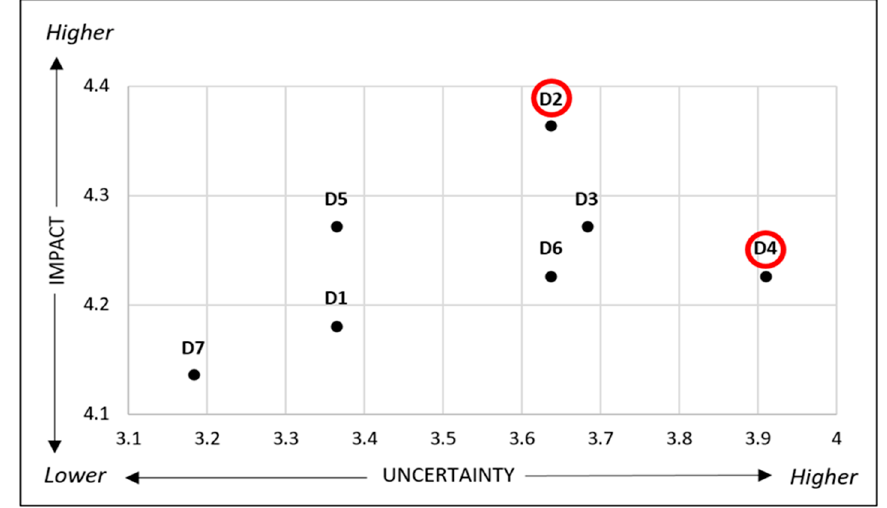
Figure 1. Impact—Uncertainty analysis.